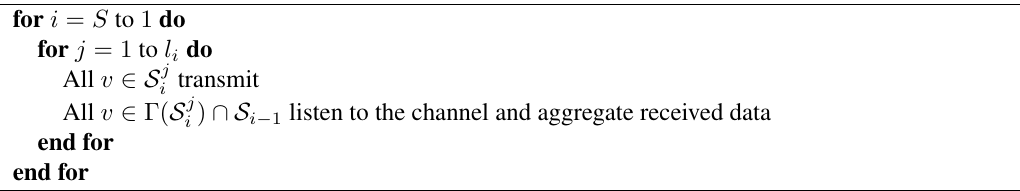
Algorithm 2 Algorithm for data